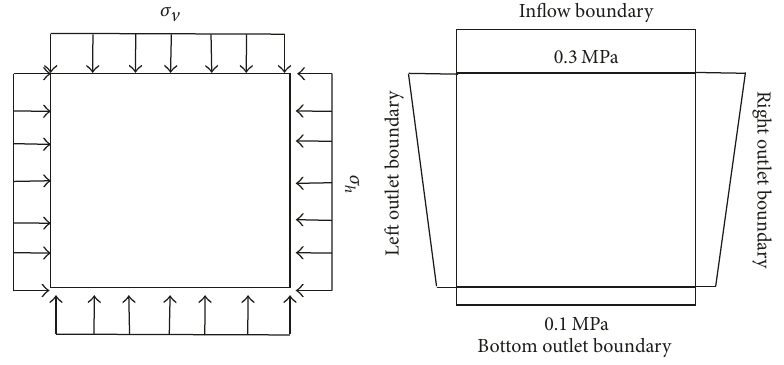
Figure 9: Hydromechanical boundary condition.